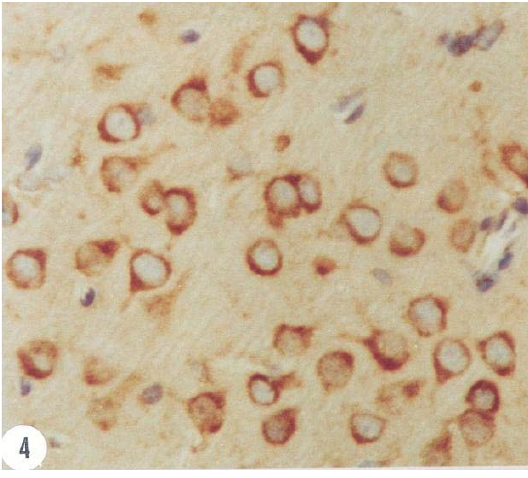
Figure 4. Increased NSE immunoreactivity in neurons 48 hr after low dose envenoming.